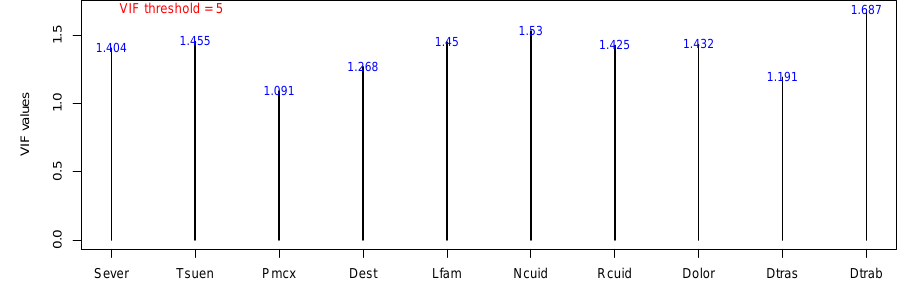
Figure 6. Variance inflation factor (VIF) of each predictor variable of ( 3 ). The tolerable limit to avoid collinearity problems between variables is 5.